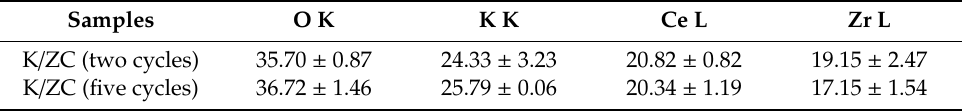
Table 2. Elemental ratio (wt%) in K / ZC (second cycles and five cycles) compositions as per the EDS data.